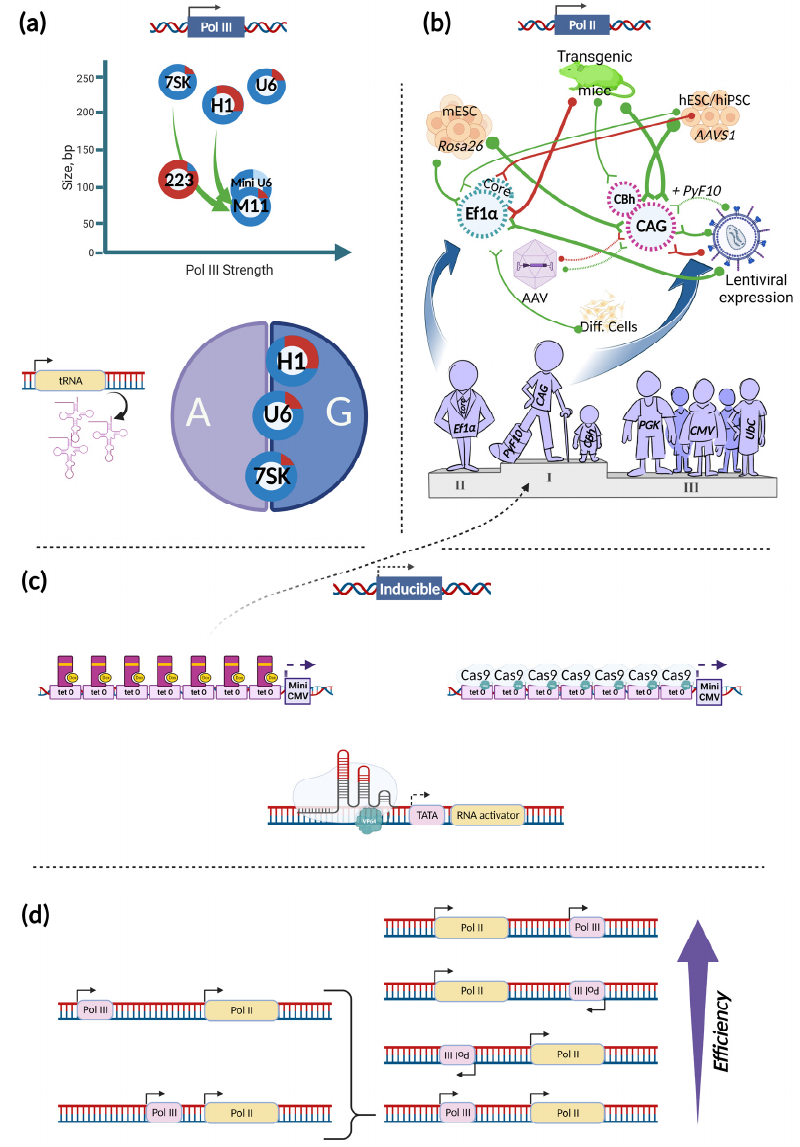
Figure 1. Promoter selection guide. ( a ) Pol III promoters are used mainly for Pol III-driven gRNA expression (blue sectors), but also can direct Pol II-dependent transcription (red sectors). The light blue sector for Mini U6 indicates that its Pol II activity has not been assessed. The size of the sectors reflects promoter activities. H1, U6, and 7SK position within the A/G circle indicates the importance of the corresponding nucleotide (A or G) in the position of transcriptional activation (+1). tRNA promoter, as an option for Pol III-driven transcription is depicted separately on the left of the A/G circle; ( b ) Pol II promoters vary in their activities depending on context. Green and red neuron-like connections summarize previous cases of successful (green) and unsuccessful (red) use of indicated promoters in different cell, vector, and application contexts. Line thickness reflects the amount and consistency of relevant literature for each of the cases; ( c ) Three examples of inducible promoters, including the conventional tet-ON promoter, its CRISPR-modification, and fully synthetic compact inducible promoter that is based on TATA box, RNA activator and CRISPR-activator binding site. The dashed arrow indicates the ability of the inducible promoter to drive the expression of the transgene on the level comparable to the best Pol II promoters; ( d ) Summary of the positional effect of Pol III and Pol II promoters on editing efficiency. A brace indicates variants with different distances between the promoters. Figure was created using